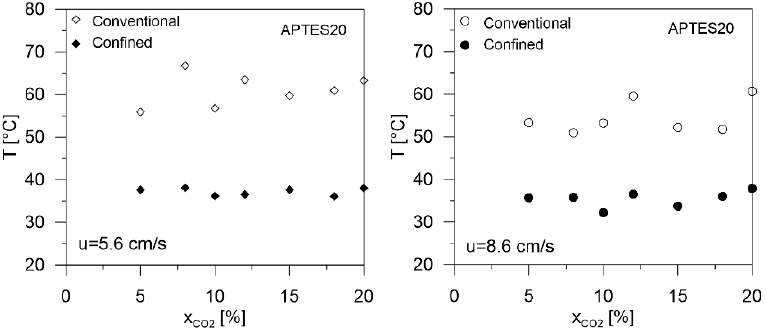
Figure 20. Temperature trend as a function of CO 2 concentration for APTES20 at different contact modes and at two velocities. Table 6. Characteristic parameters of the adsorption tests on APTES20 for different values of gas velocity, for different layouts, and at varying inlet gas concentrations of CO 2 . (* FB: fixed bed; BB: bubbling bed; CEB: confined expanded